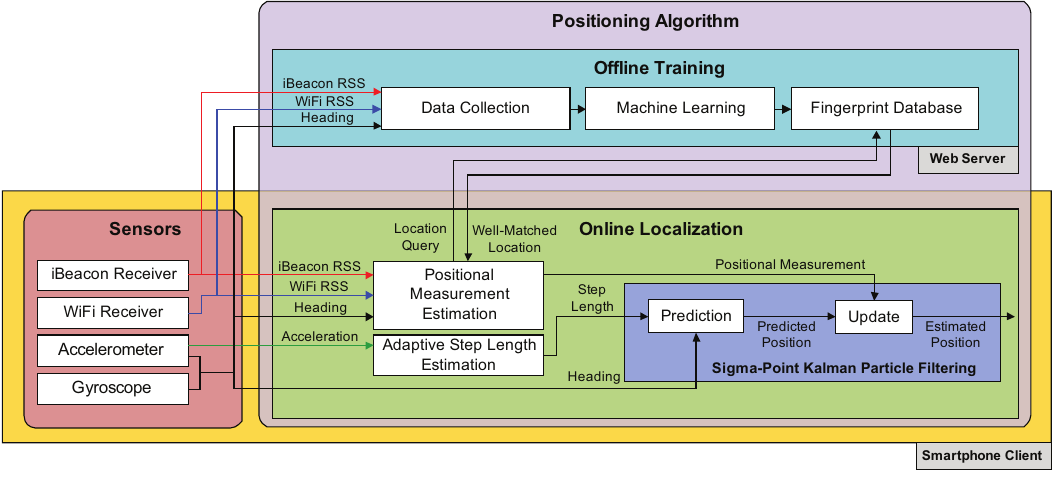
Figure 1. Overall architecture of our positioning